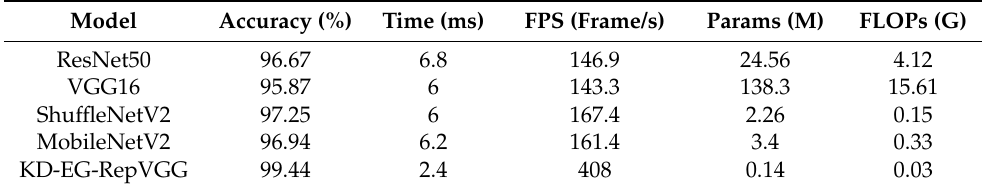
Table 4. Comparison of test results for different